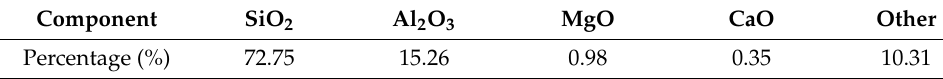
Table 5. Chemical composition of clay (%).